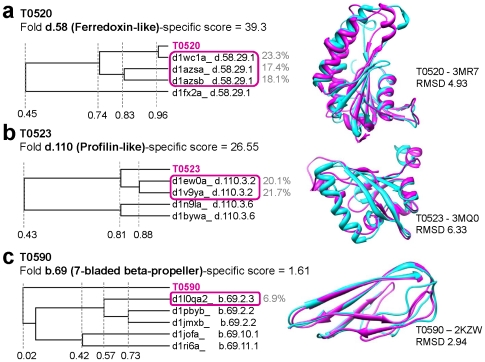
Structure prediction of CASP9 targets.The structures of the three targets T0520, T0523, and T0590 from CASP9 were predicted based on the folds predicted FSL. First, the fold of each target was determined as the fold with the highest fold-specific score. To select the best template structures from the fold, all SCOP domains in the fold (SCOP 1.75) and the target were represented in a vector of (percent identity  percent coverage) score of an alignment to each PSSM in the fold-specific library and then performed hierarchical clustering using Pearson's correlation coefficient as a similarity metric. The SCOP domains which have high Pearson's correlation coefficients to the target were selected as template structures for template-based structure modeling (purple boxes in a dendrogram). Sequence identity between the SCOP domains and the target is in the twilight zone (grey text). The sequences of the selected SCOP domains and the target were aligned using MUSCLE. Given the alignment, Modeller was used to predict a structure. Structural superposition of each target to its experimental structure is given (cyan: experimental structure, purple: our model).